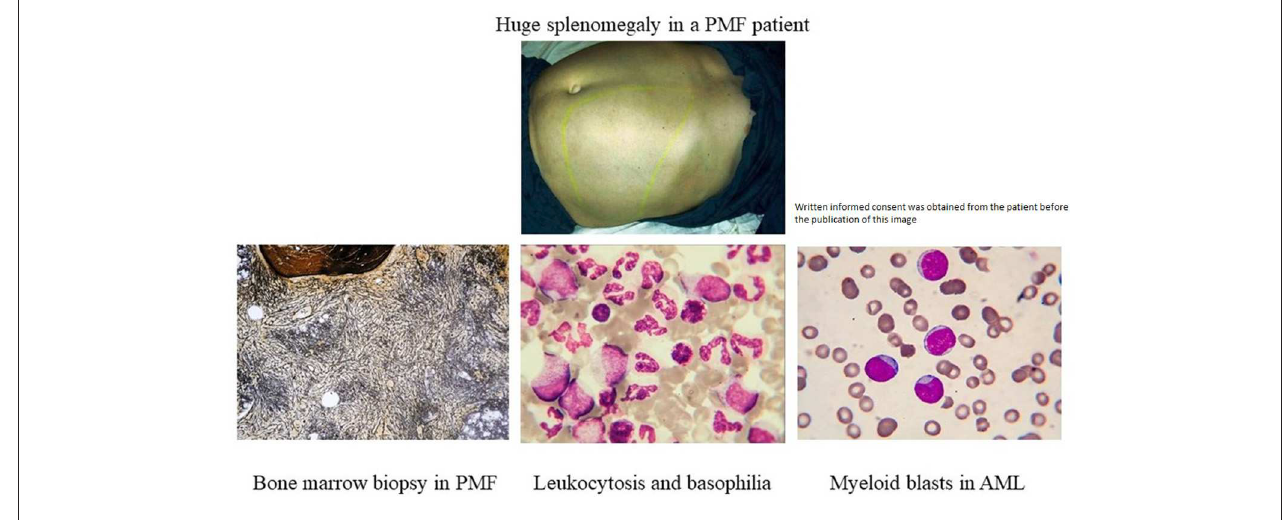
FIGURE 4 | Clinical evolution of a patient with basophilia towards acute myeloid